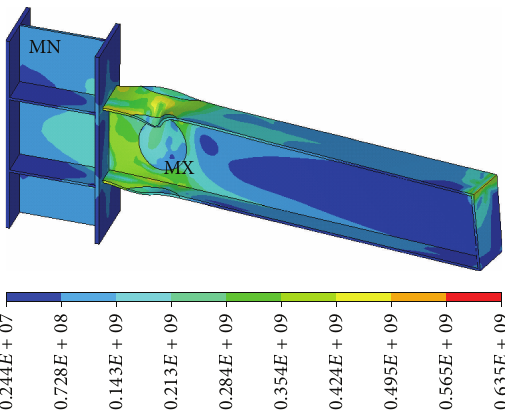
Figure 15: Stress of replaceable connection